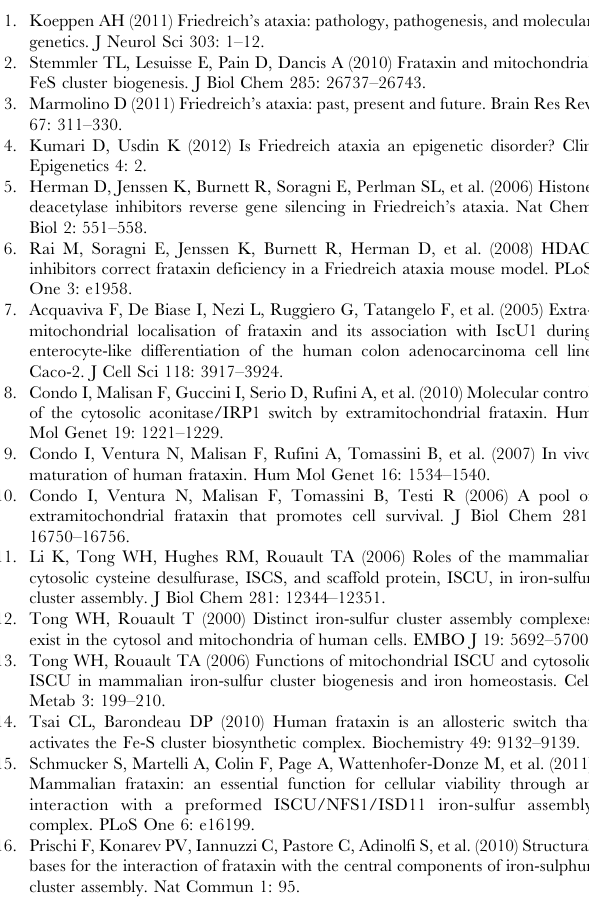
Figure S3 High iron binding activity of FXN III is correlated with its high capacity for iron-sulfur cluster assembly. Anaerobic iron-sulfur cluster assembly in vitro was performed with or without FXN isoforms and the kinetic spectrum was scanned with 15 min interval within 90 min. B Iron content was determined by inductively coupled plasma atomic emission spectroscopy. E. coli were cultured in LB growth medium with or without iron addition for FXN over-expression. FXN proteins were purified and subject to iron content determination. Table S1 Primer pairs used in this